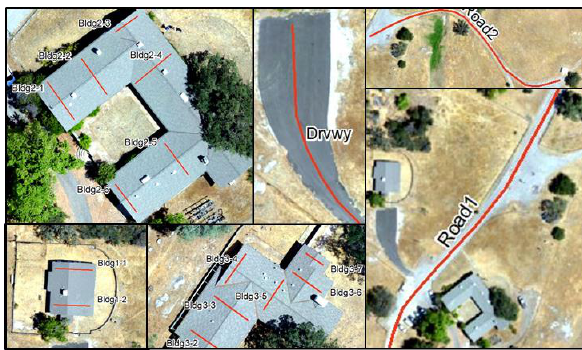
Figure 3. Features and profile paths for elevation profile analysis.